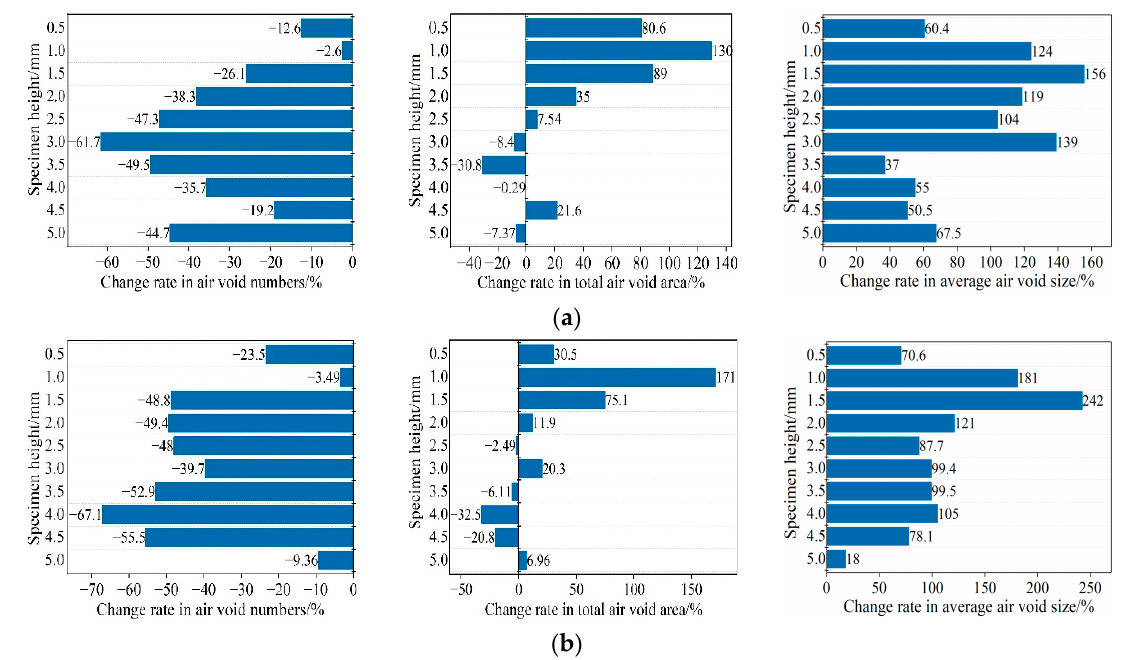
Figure 14. Variation of air-void characteristics in rutting test: ( a ) AC-13; ( b ) AC-16.